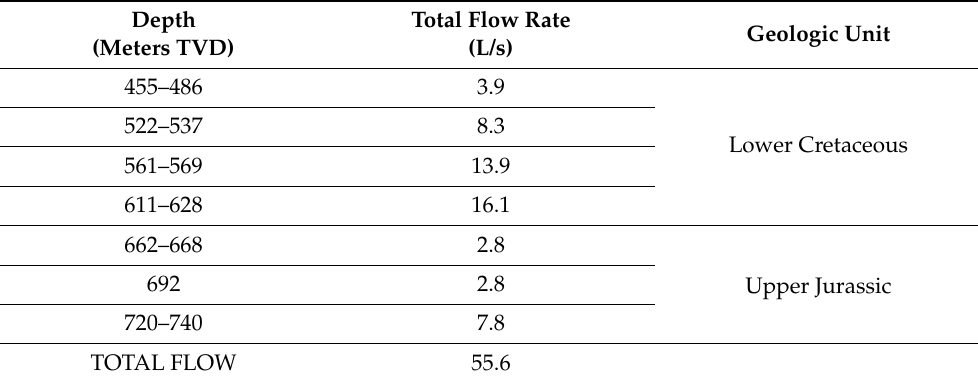
Figure 2. Schematic technical and stratigraphic characteristics of the GEo-01 and Thonex-01 wells (mod from [4,7,11]). Table 1. Productive intervals in the GEo-01 well